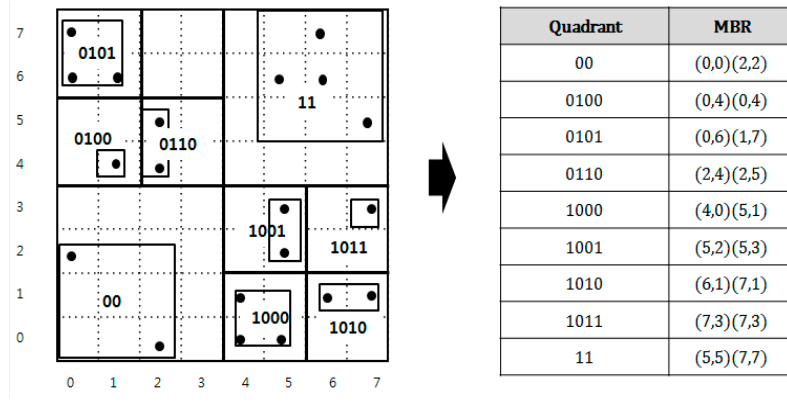
Figure 3. An example of QbMBR creation.